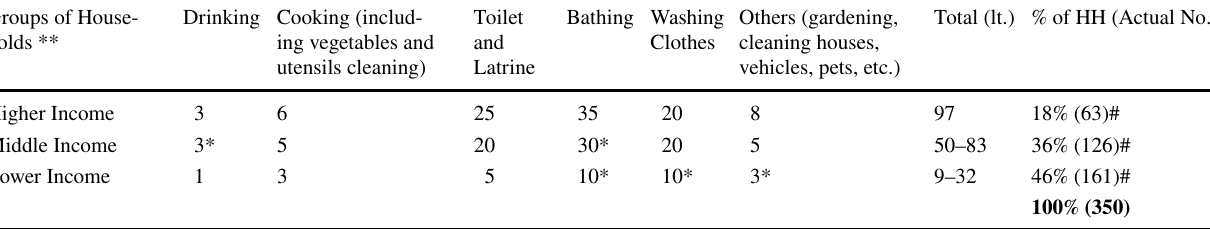
Table 4 Per capita water use of different user groups. Source : Field Survey,